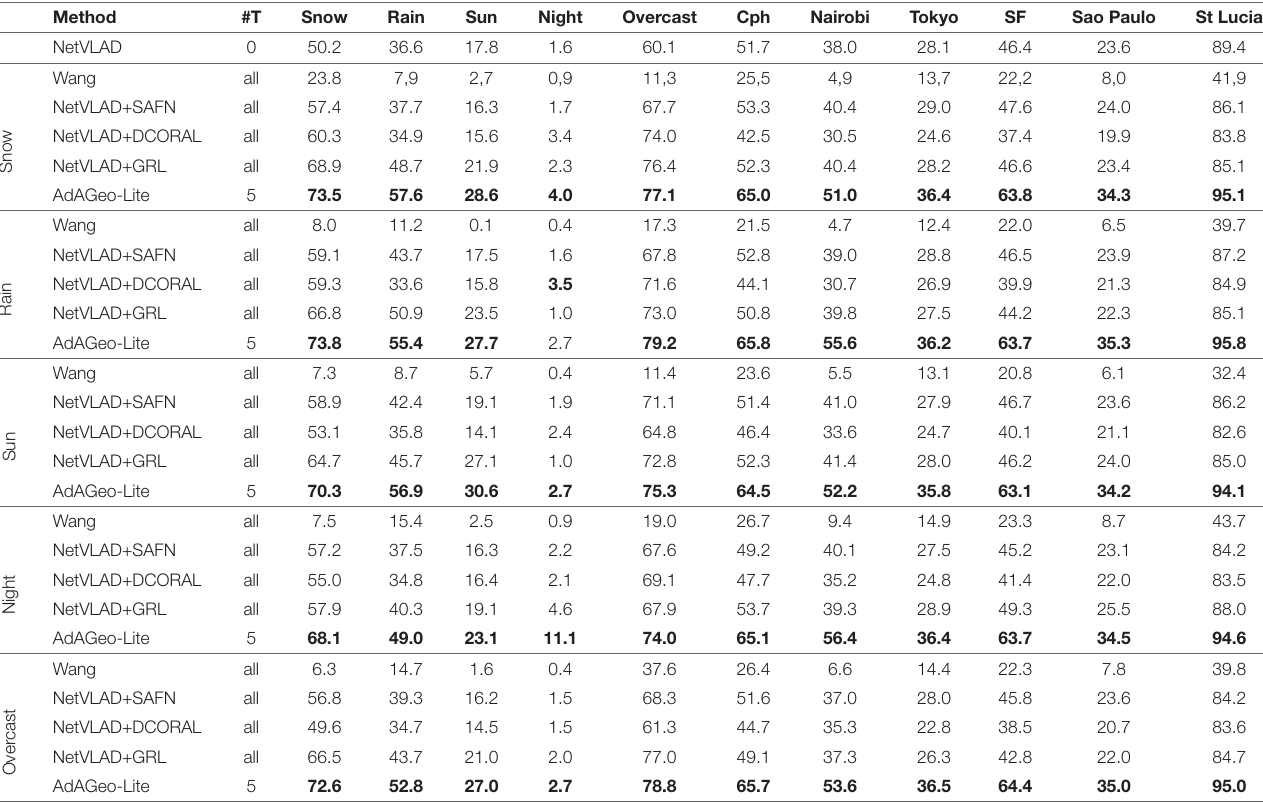
TABLE 4 | Domain generalization results: comparison between all methods, shown as recall@1 (R@1) on each target domain. Method